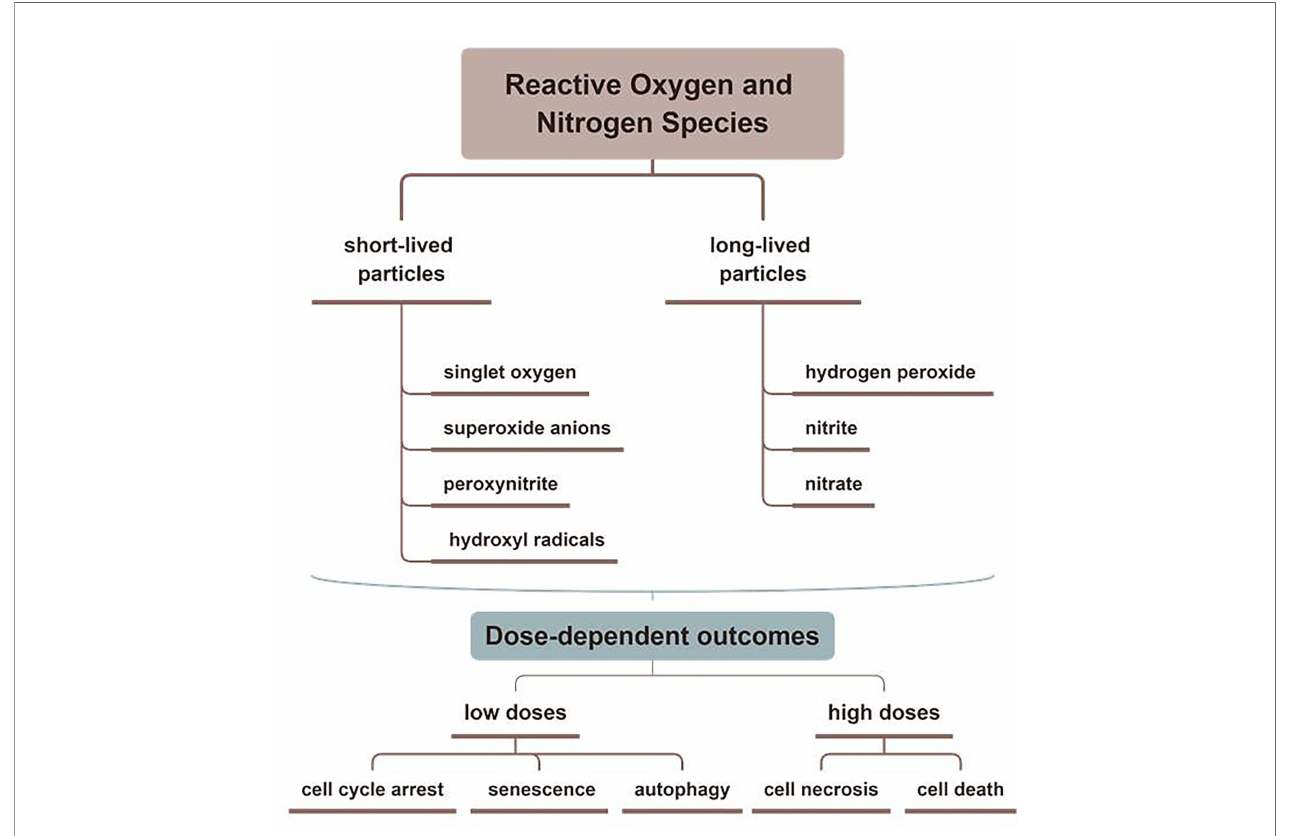
FIGURE 3 | The typical functions of ROS and RNS in CAP. Various kinds of effective particles, including ROS and RNS, are divided into short-lived or long-lived substances, which display different mechanisms in treating skin diseases by